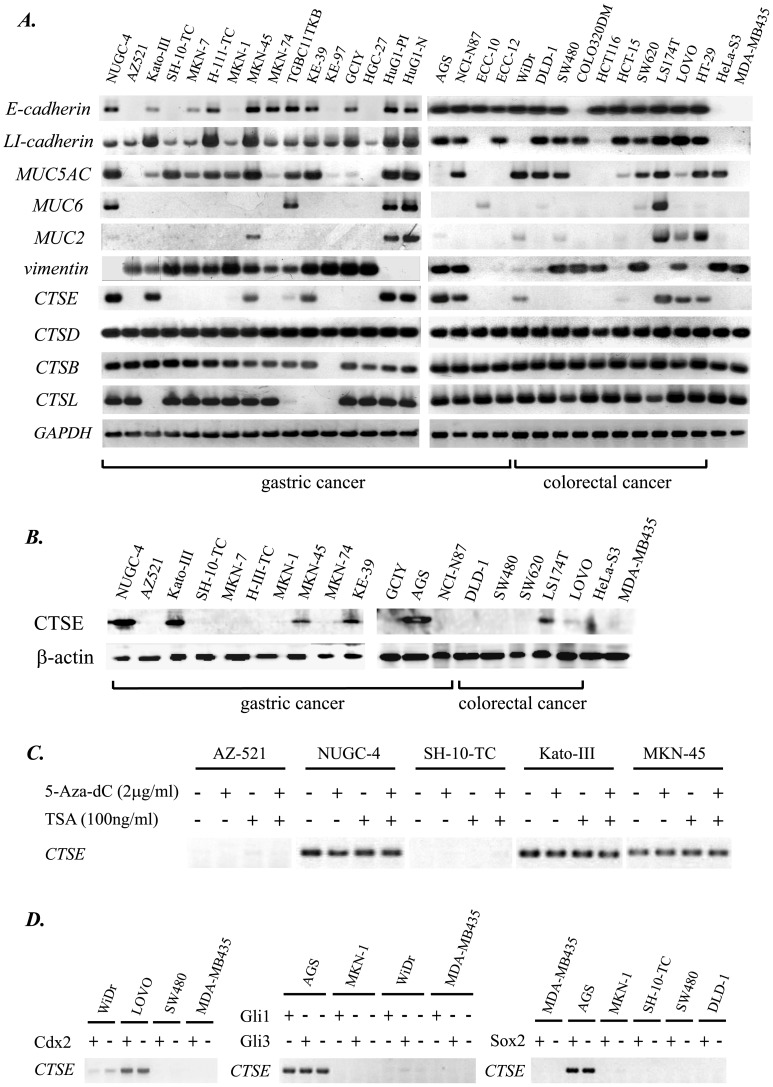
(A) Expression of E-cadherin, LI-cadherin, MUC5AC, MUC6, MUC2, vimentin, CTSE, CTSD, CTSB, CTSL, and GAPDH (internal control) mRNAs in a panel of 32 human cancer cell lines.20 gastric, 10 colorectal, and 2 non-gastrointestinal cell lines (HeLa-S3 and MDA-MB435) were analyzed by RT-PCR. (B) Expression of CTSE protein in 13 gastric, 5 colorectal, and 2 non-gastrointestinal cancer cell lines analyzed by Western blotting. (C) RT-PCR detecting CTSE mRNA in 5 gastric cancer cells treated with 5-Aza-dC and/or TSA for 48 hours. (D) RT-PCR detecting CTSE mRNA in gastric (AGS, MKN-1, SH-10-TC), colorectal (WiDr, Lovo, SW480, DLD-1), and breast cancer (MDA-MB435) cell lines stably transduced with retroviral vector encoding cdx2, gli1, gli3, or sox2 genes.